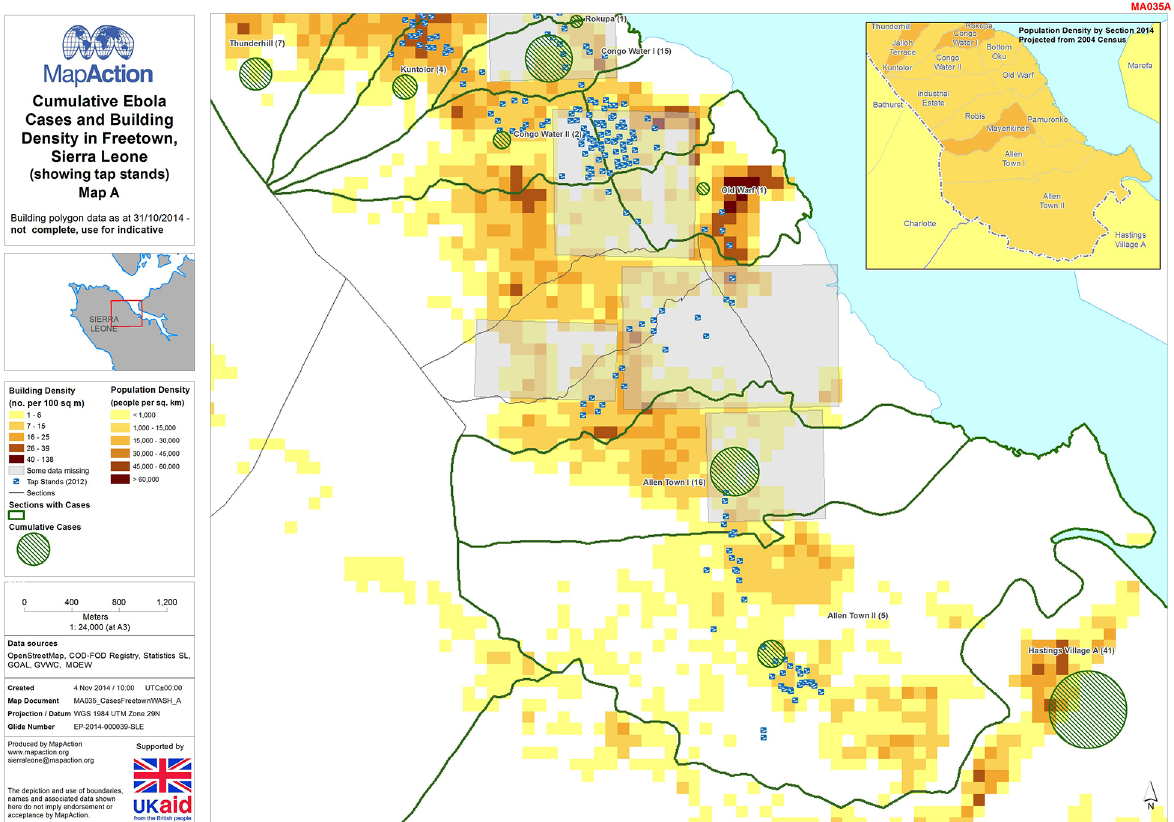
Fig. 9. Map provided by MapAction for a sector of Freetown (Sierra leone) overlaying Ebola cases with building density. Source: https://maps.mapaction.org/dataset/232-3611